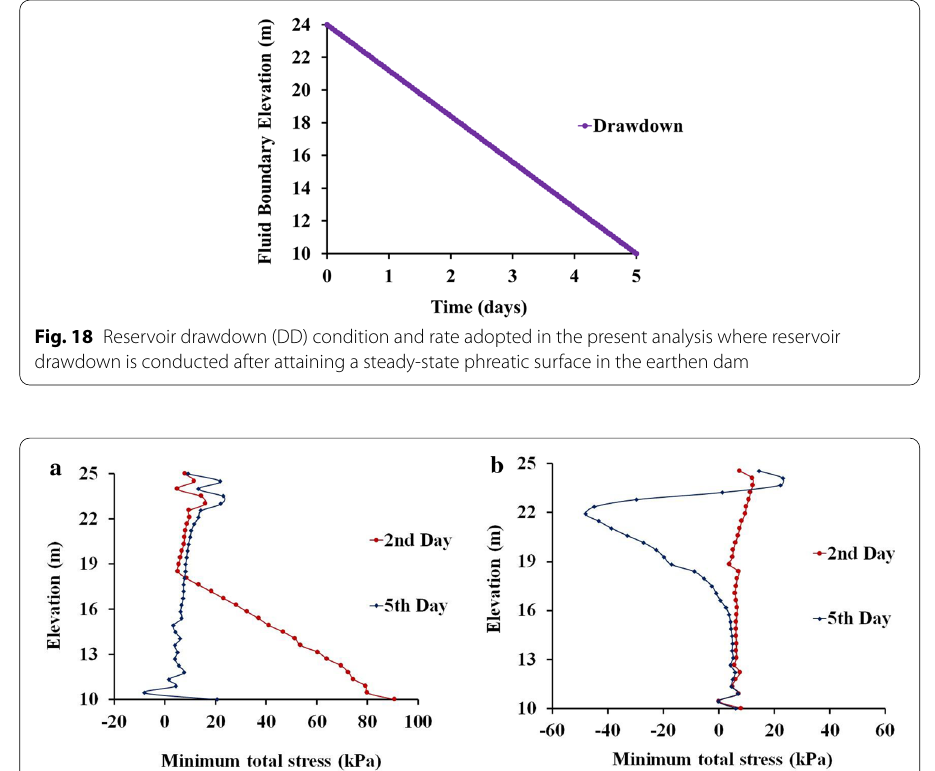
Fig. 19 Variation of minimum total stress in the earthen dam pertaining to reservoir drawdown operation initiated after the steady-state phreatic surface is attained a upstream face, b downstream